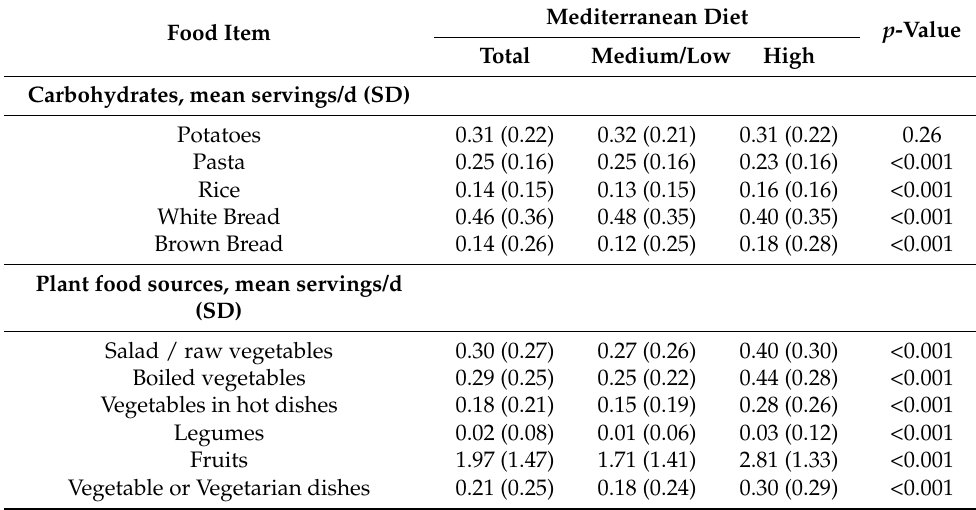
Table 3. Consumption (servings per day) of selected food groups by level of adherence to the Mediterranean